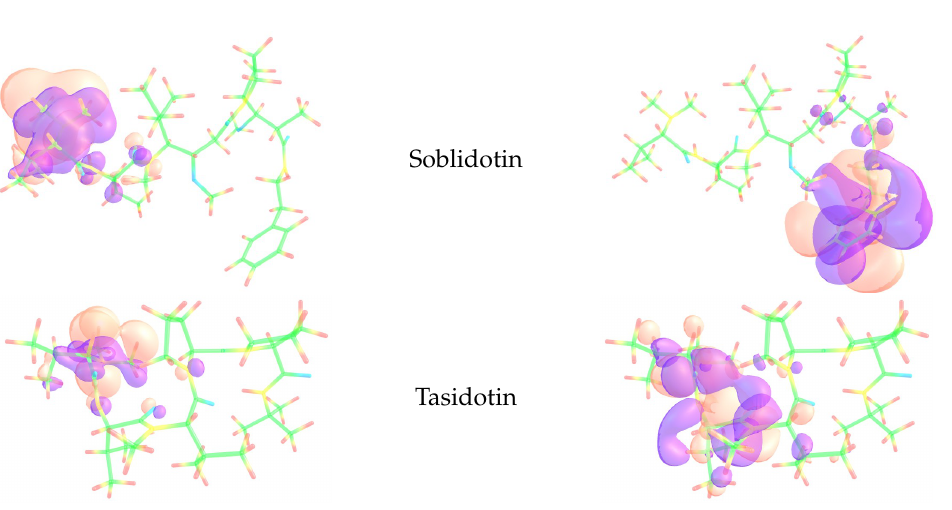
Figure 3. Graphical sketches of the HOMO and LUMO of the Soblidotin and Tasidotin marine peptides as approximations to the electrophilic ( left column) and nucleophilic ( right column) Fukui